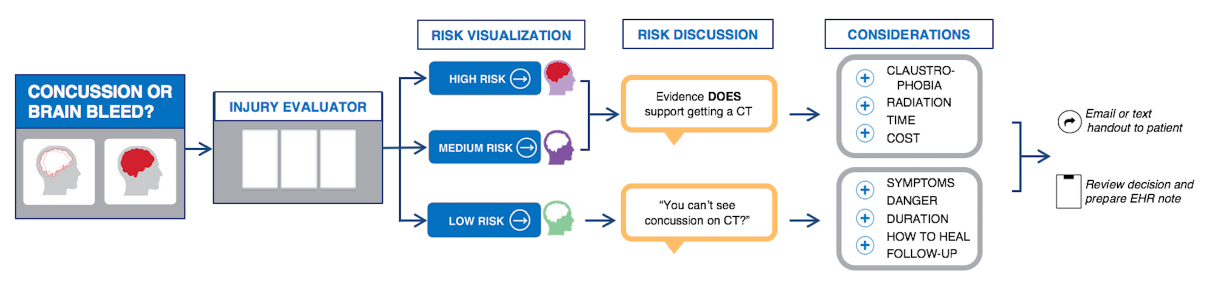
Figure 1. Conceptualization of the workflow and potential pathways for the Concussion or Brain Bleed app. CT: computed tomography; EHR: electronic health